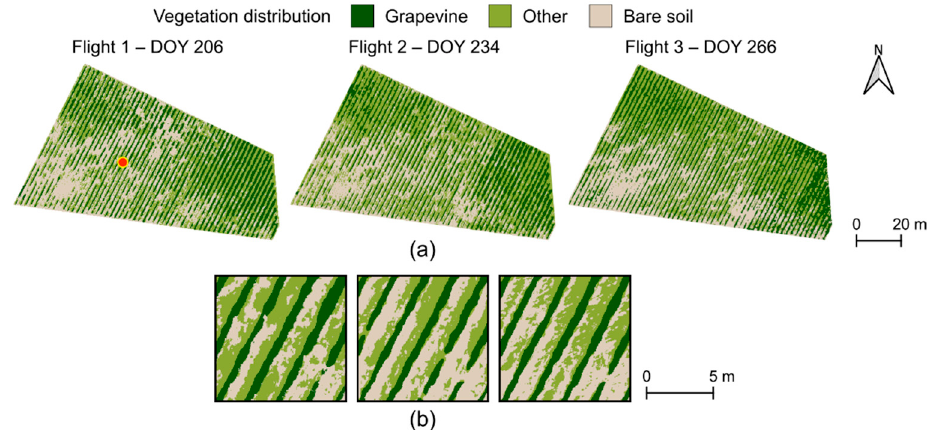
Figure 7. Vegetation and soil distribution in the three flight campaigns at different grapevine phenological stages: ( a ) vineyard plot overview and ( b ) close view of the point highlighted in flight 1.